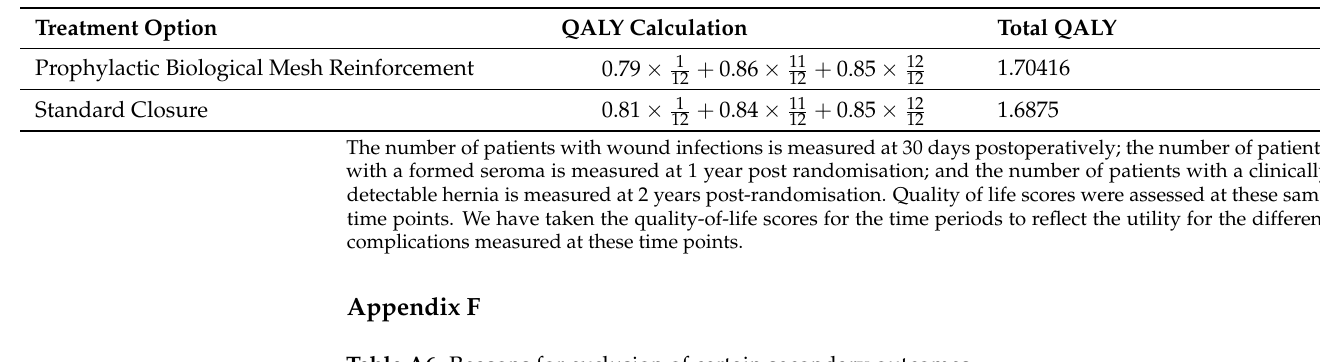
Table A6. Reasons for exclusion of certain secondary outcomes.